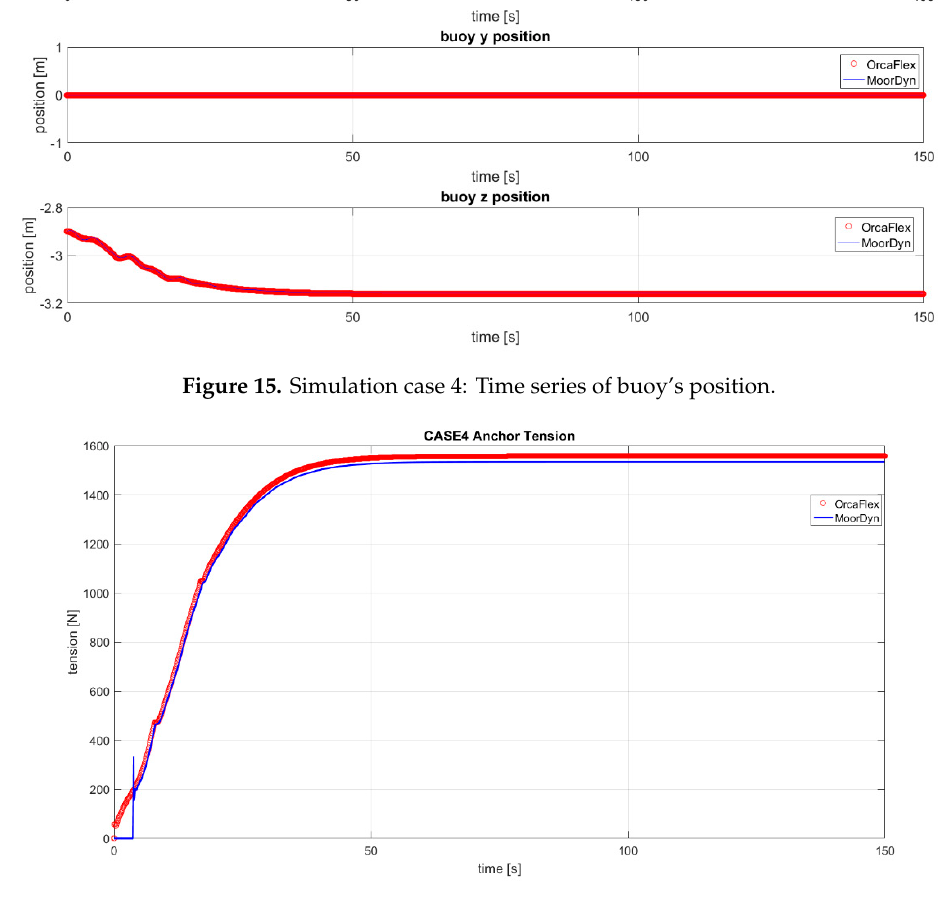
Figure 16. Simulation case 4: Time series of anchor tension.